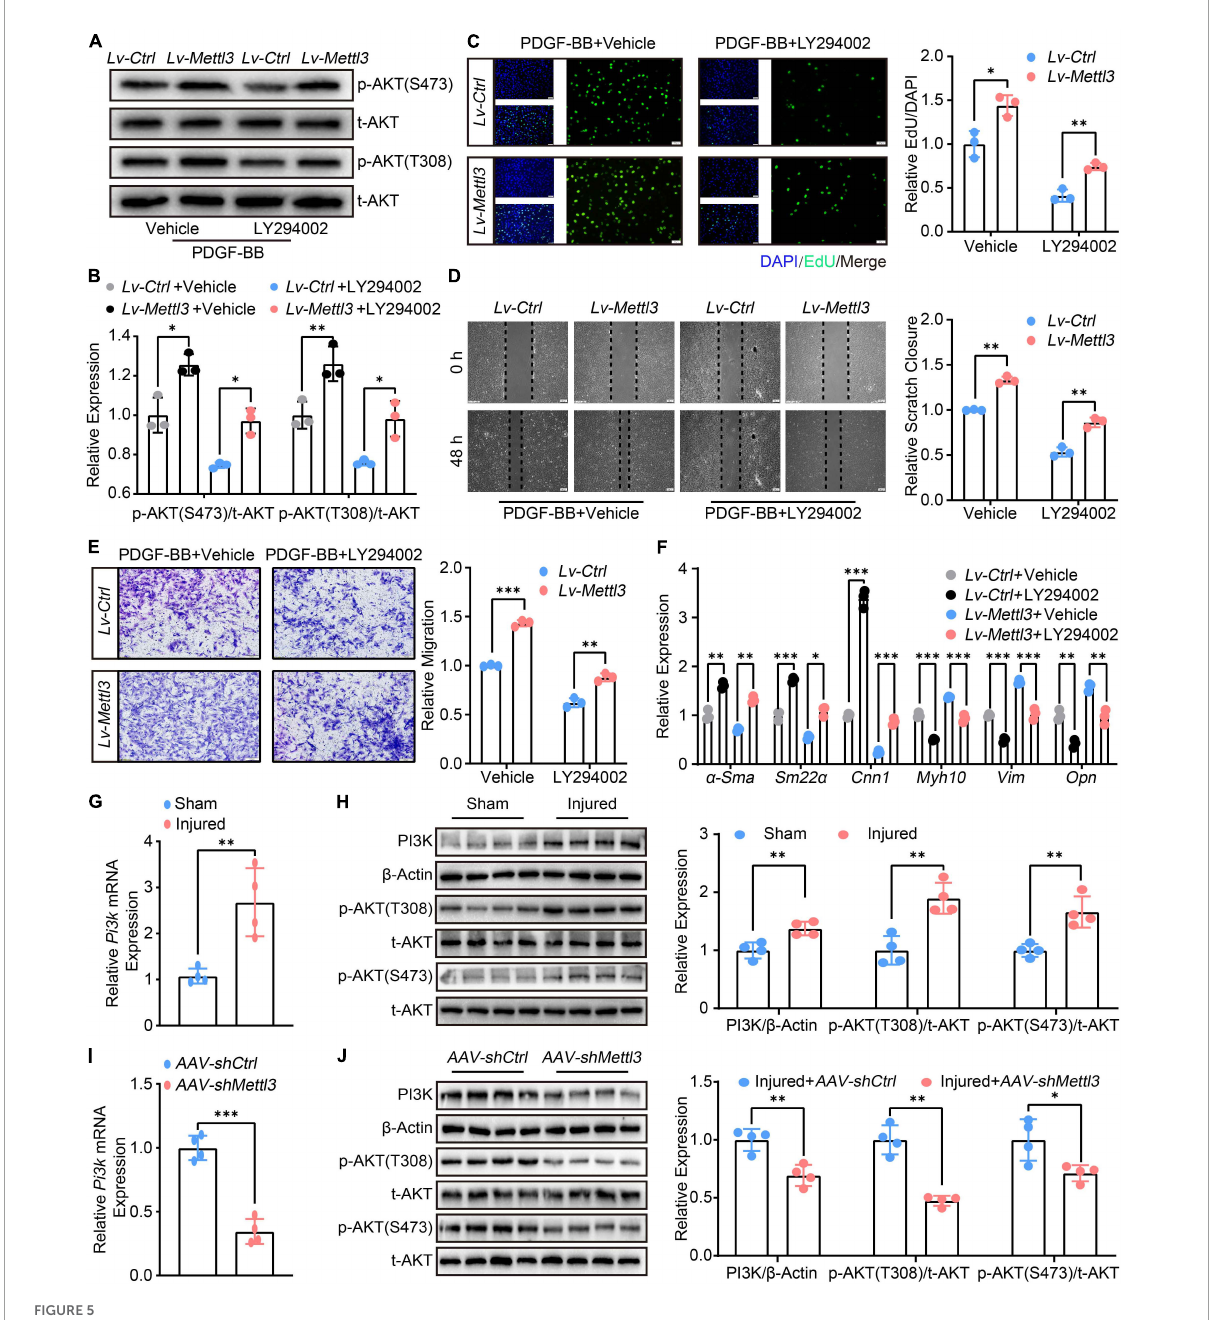
FIGURE5 Methyltransferase like 3 (METTL3) regulates the phenotype switching of vascular smooth muscle cells (VSMCs) is PI3K-dependent. (A,B) Representative Western Blot images showing the impact of LY294002 on p-AKT(T308) and p-AKT(S473) expression upon Lv-Ctrl or Lv-Mettl3 transfection. (C) Representative EdU images [(left panel), scale bar = 50 µ m] and quantitative analysis (right panel) of LY294002 treating or not on VSMCs proliferation. Three randomly selected fields for each sample were acquired ( n = 3). (D) Representative Scratch images [(left panel), scale bar = 200 µ m] and quantitative analysis (right panel) of LY294002 treating or not on VSMCs migration. Three randomly selected fields for each sample were acquired ( n = 3). (E) Representative transwell images [(left panel), scale bar = 100 µ m] and quantification of VSMCs migration (right panel). Three randomly selected fields for each sample were acquired. (F) Quantitative RT-qPCR analysis of α - Sma , Sm22 α , Cnn1 , Myh10 , Vim , and Opn expression ( n = 3). (G) Quantitative analysis of Pi3k mRNA expression in carotid arteries subjected to balloon-injured or sham-operated ( n = 4). (H) Western Blot image (left panel) and quantification (right panel) of PI3K, t-AKT, p-AKT(T308), and p-AKT(S473) levels from the carotid arteries subject to balloon-injured and sham-operated ( n = 4). (I) Quantitative analysis of Pi3k mRNA expression in carotid arteries subjected to balloon-injured or sham-operated after AAV-shCtrl or AAV-shMettl3 delivery ( n = 4). (J) Western Blot image (left panel) and quantification (right panel) of PI3K, t-AKT, p-AKT(T308), and p-AKT(S473) proteins from the carotid arteries subject to balloon-injured and sham-operated after AAV-shCtrl or AAV-shMettl3 delivery ( n = 4). Data are presented as mean ± SD. ∗ p < 0.05, ∗∗ p < 0.01, and ∗∗∗ p <